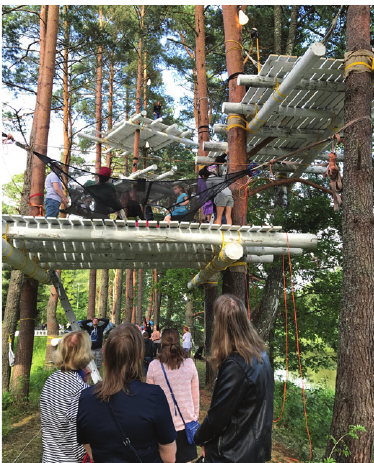
Figure 4. International Summer School The Big Reset on Neighbourhood Design Series 4, 2017: Islands in the stream . Presentation